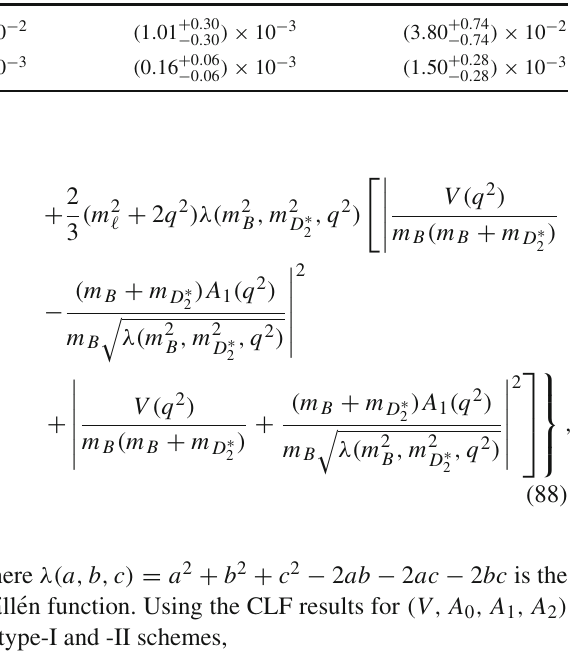
(cid:5) + ν (cid:5) ( (cid:5) = e ,μ ) and B → ¯ D ∗ τ + ν τ decays. The errors are caused by the form Table 8 Numerical results for the branching fractions of B → ¯ D ∗ 2 2 factors given in Eqs. (89,90) Type-II Type-I Ref. [67] Ref.